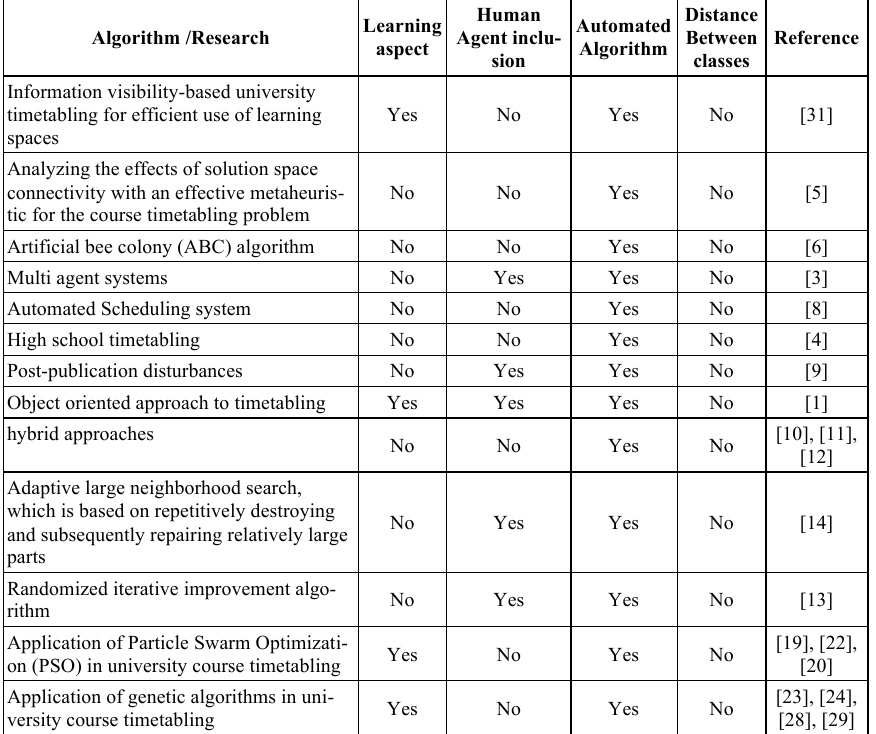
Table 1. : Summary